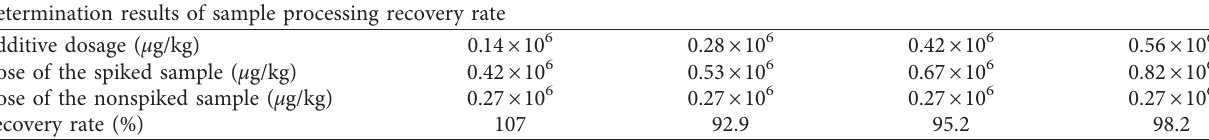
Table 4: Determination results of sample processing recovery rate.